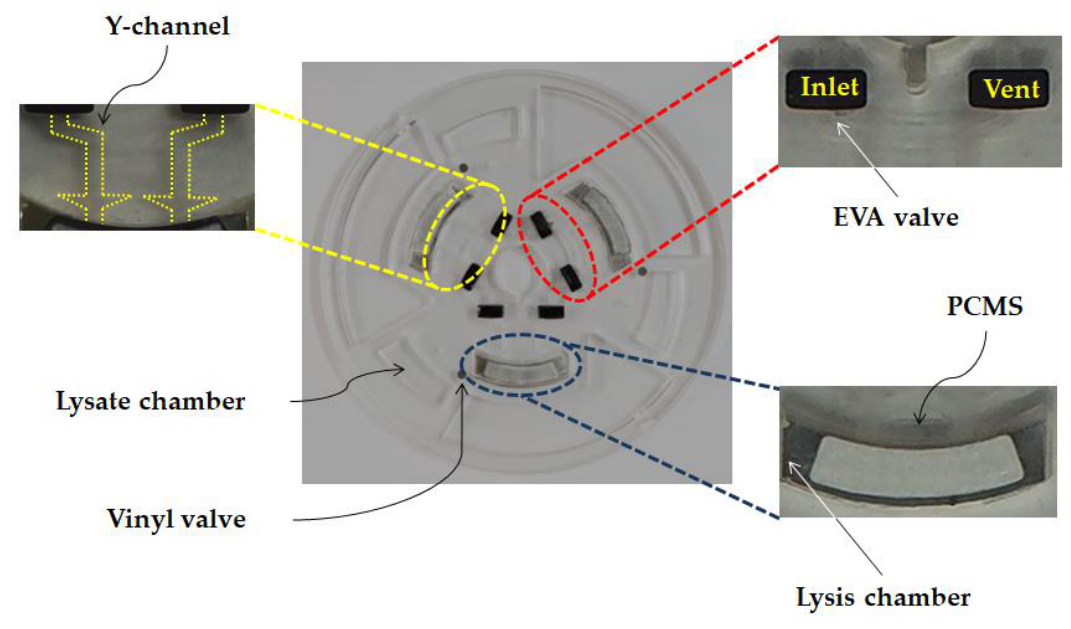
Figure 5. LOD design showing the detail of microfluidic layout and functions.